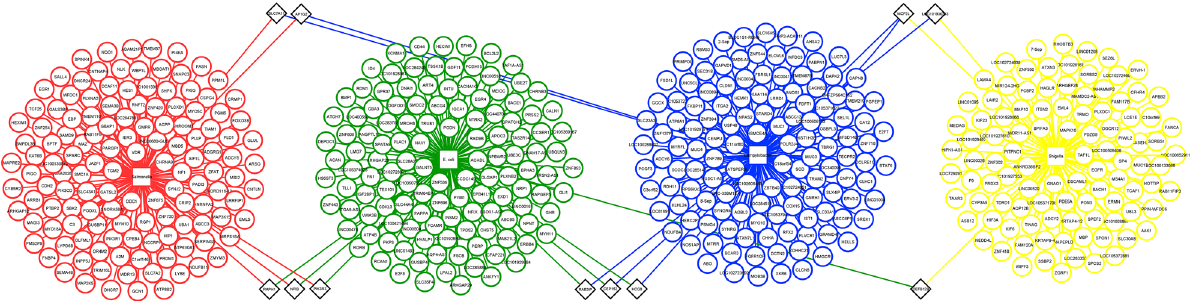
Figure 3. The common downregulated DEGs (black colored diamond boxes) found in the pathogenesis of four bacterial species. DEGs from Salmonella, E. coli, Shigella, and Campylobacter infection are shown in red, green, yellow, and blue colors, respectively.